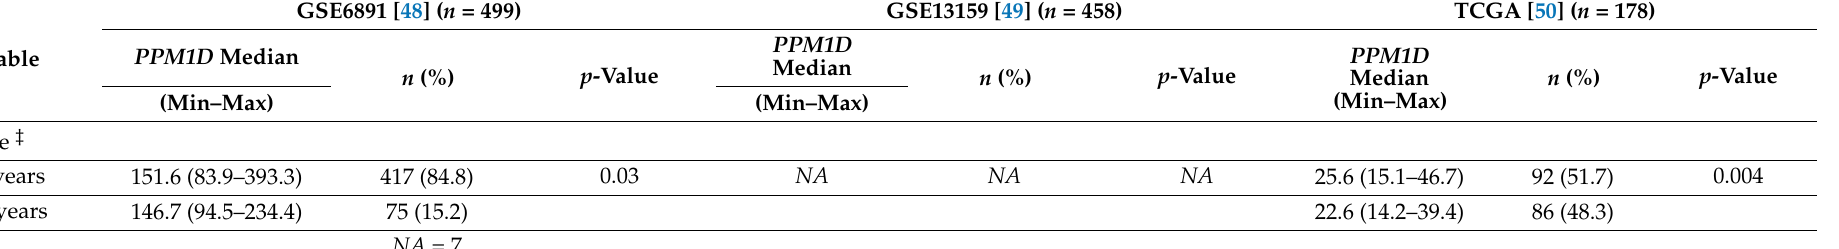
Table 1. Association between PPM1D expression levels and clinical/molecular data across public